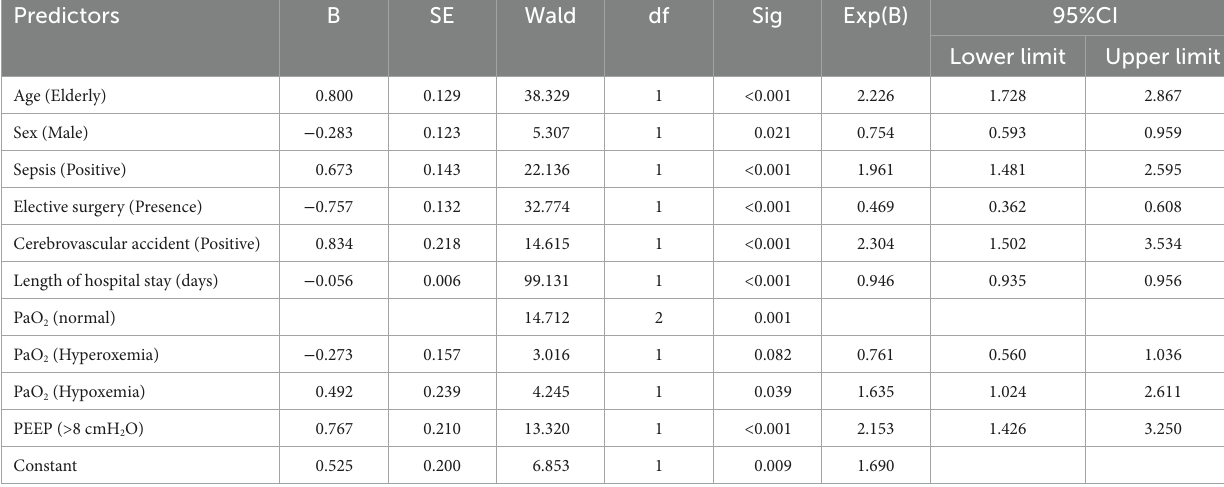
TABLE 2 Multivariate binary logistic regression analysis predicts the death of adult and old patients admitted to an intensive care treatment unit. Predictors